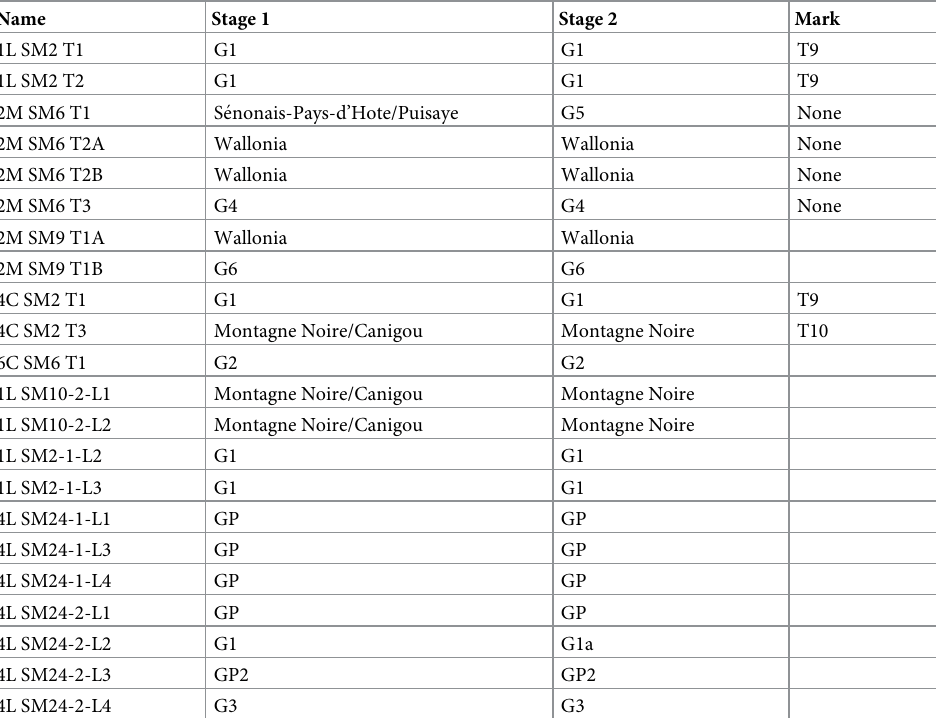
Table 3. Summary of the results of the statistical